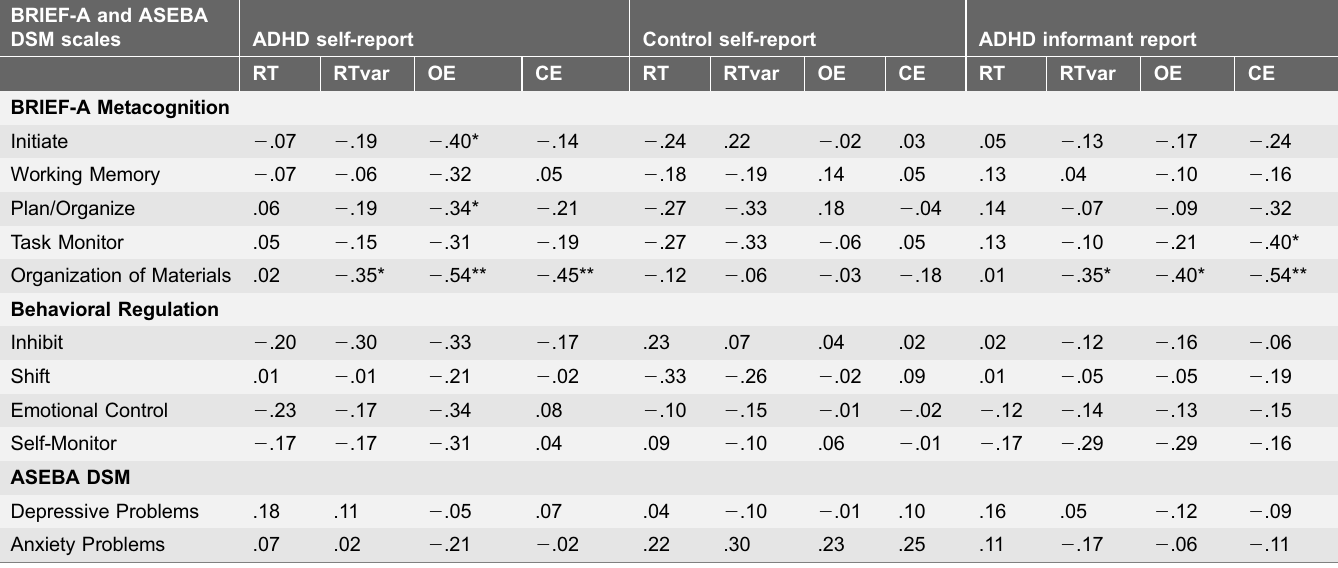
Table 4. Correlations of T.O.V.A. performance with BRIEF-A and ASEBA DSM self-report for the ADHD group and the healthy control group, and of the ADHD patients’ T.O.V.A. performance with BRIEF-A and ASEBA DSM informant-report for patients. BRIEF-A and ASEBA DSM scales